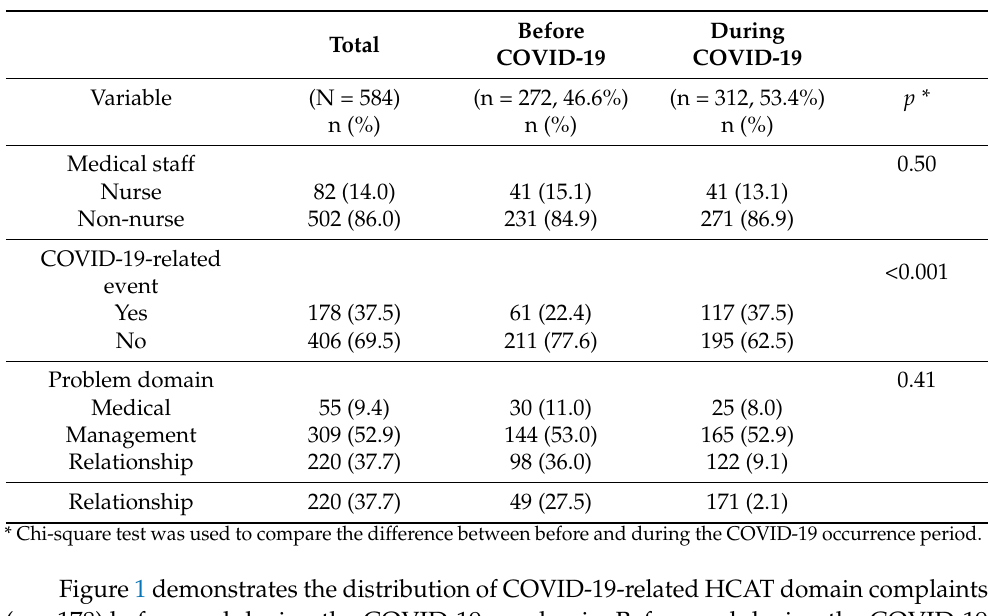
Table 3. Analysis of the healthcare complaints analysis tool domains and problems before and during the COVID-19 occurrence period.